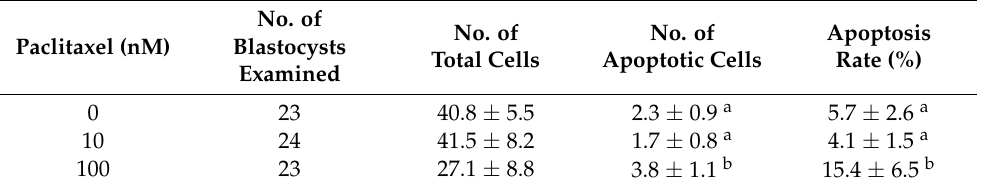
Table 4. Terminal deoxynucleotidyl transferase-mediated dUTP nick-end labeling (TUNEL)-positive cell rate in blastocysts after paclitaxel treatment. No. Paclitaxel (nM)